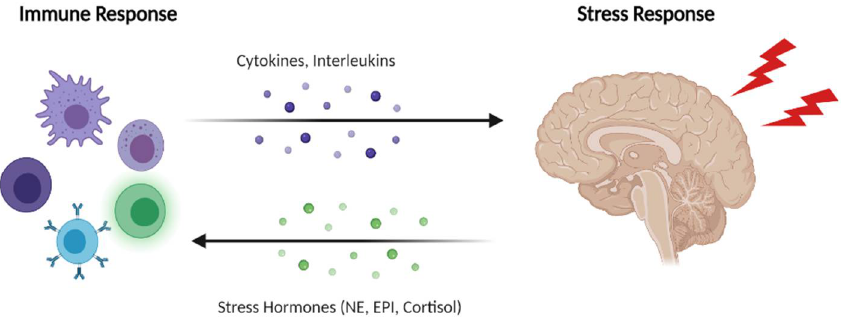
Figure 3. Connection between immune and stress responses. The immune system and the stress response are linked through various players, such as interleukins, cytokines, and various hormones. This link between these systems can be important in the pathophysiology of several diseases, such as AD. Created with BioRender.com.